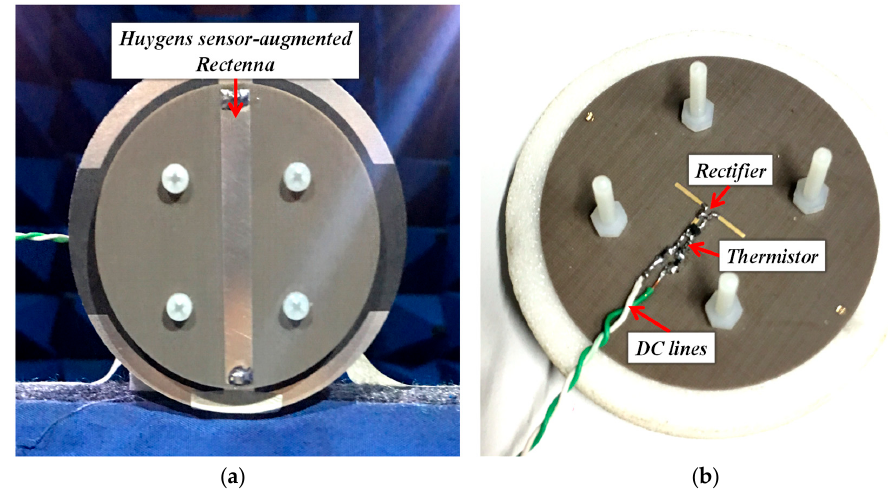
Figure 10. Fabricated and tested electrically small sensor-augmented Huygens rectenna: ( a ) front view